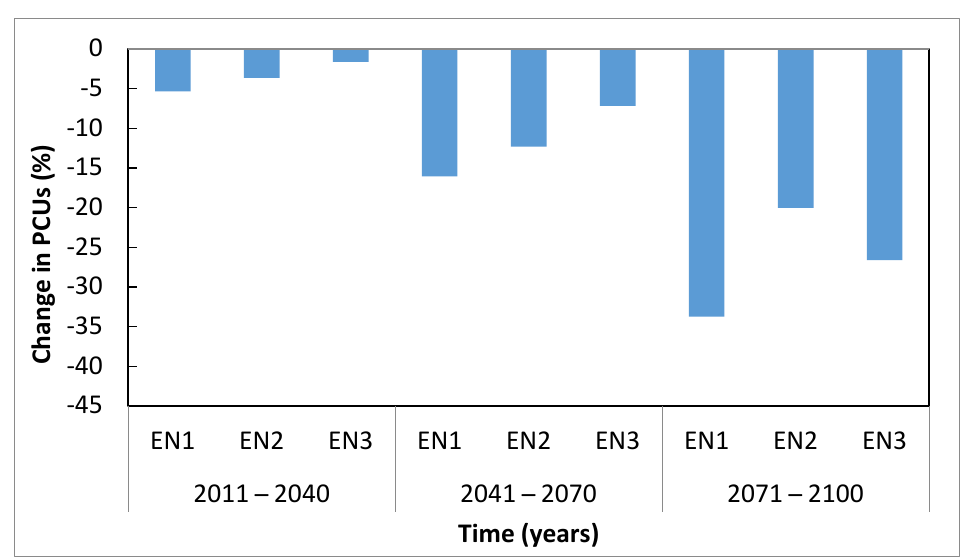
Figure 5. Projected changes in accumulated positive chill units (PCUs) for Ceres (2011–2100).